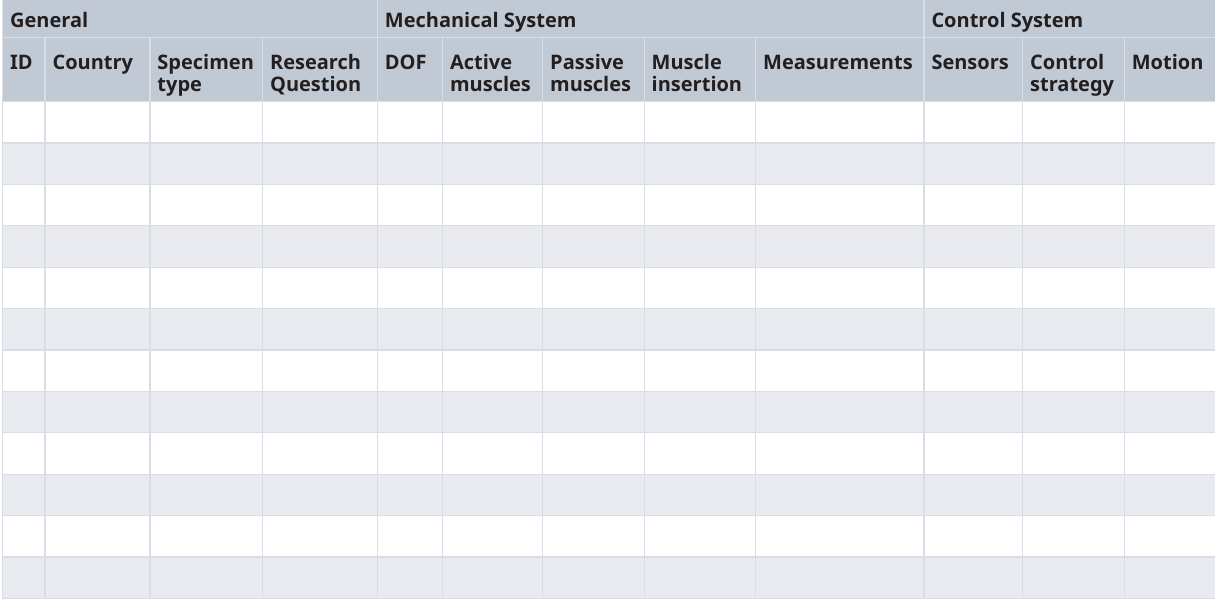
Table 1. Data extraction sheet template.